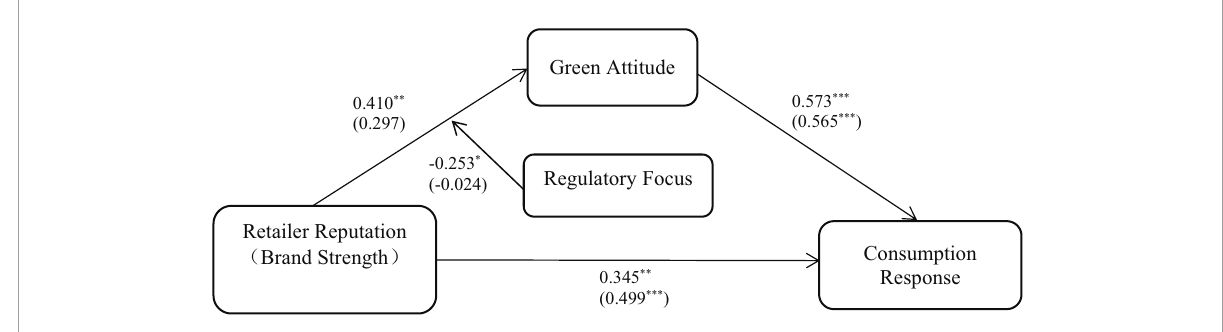
FIGURE4 Moderated mediation model for low- and high-involvement green products. The numbers in brackets are the path coefficients of the model [green attitude (M) as a mediator and regulatory focus (W) as a moderator of the effect of brand strength (X) on consumption response (Y)]. ∗ p < 0.05, ∗∗ p < 0.01, *** p <